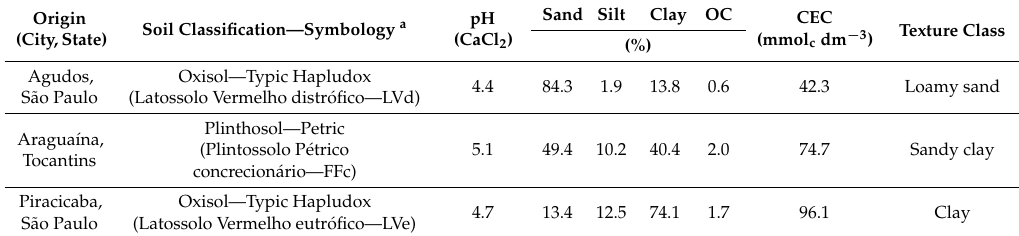
Table 2. Physicochemical properties of three tropical soils (0–10 cm of depth) studied in this experiment. Origin